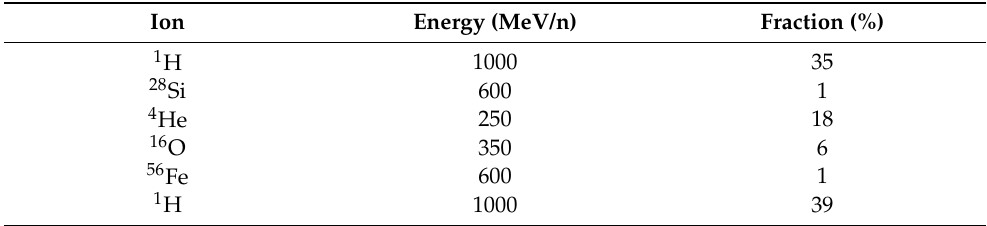
Table 3. Composition of simGCRsim irradiation used in this study, with ions listed in delivery order. Delivering 6 beams and 5 ions for simGCRsim requires about 20